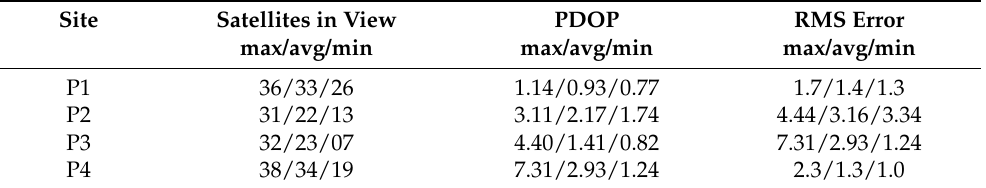
Figure 8. The performance evaluation results of a CAN-enabled GNSS receiver in quad-constellation mode in terms of fundamental quality indicators, i.e., ( a ) satellite availability, ( b ) PDOP and ( c ) RMS error over the entire experimental route containing different operating environments. Table 6. Comparison of the quad-constellation GNSS receiver performance with CAN enabled under different types of environments denoted by P1, P2, P3 and P4 observation